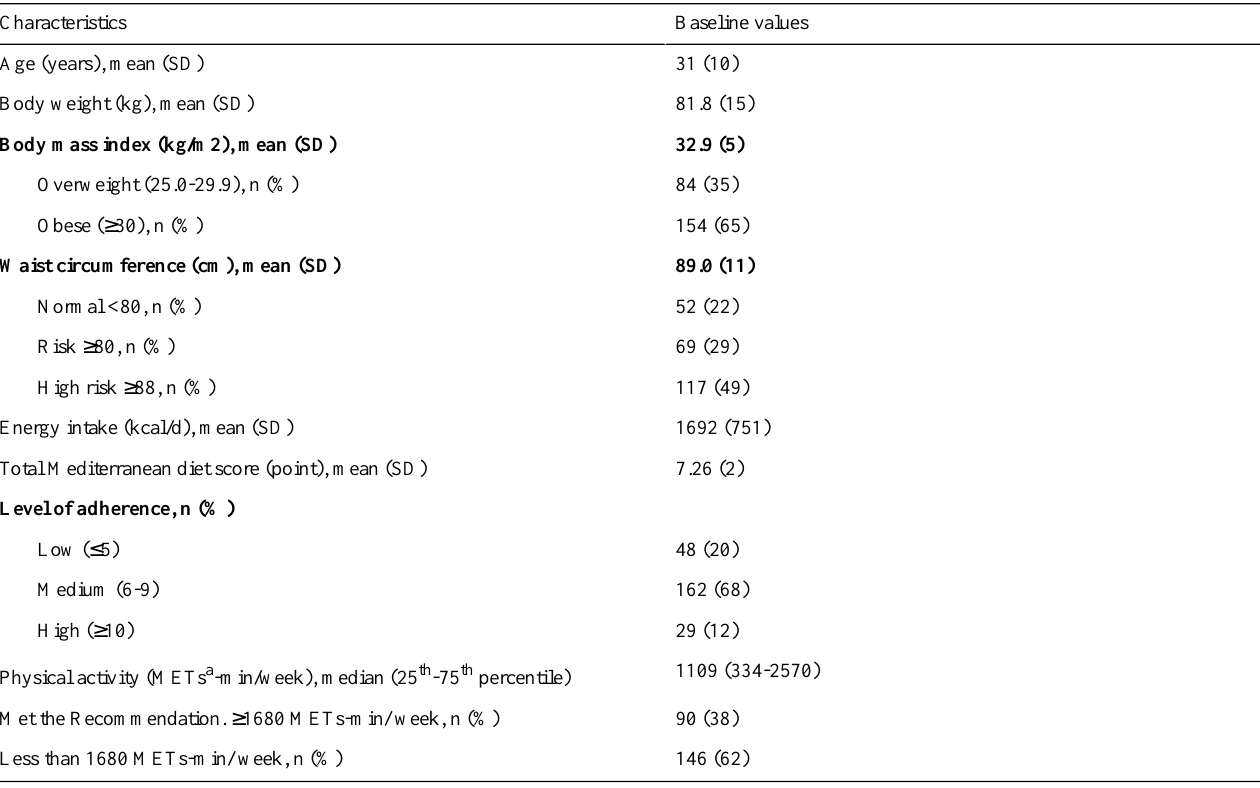
Table 1. Baseline characteristics of the 240 women.